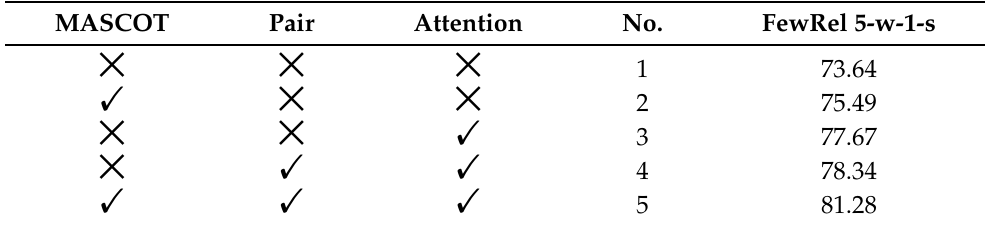
Table 7. Ablation study for our model, MASCOT is the MASCOT encoder, pair is the pair function, attention is the instance